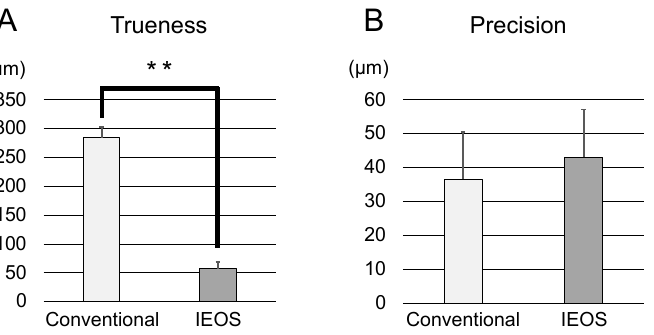
Figure 9. Results of statistical analysis (Student’s t -test, ** : p < 0.01). ( A ) Trueness. ( B ) Precision. Table 1. Mean ± SD values and statistical analysis of accuracy (trueness and precision).